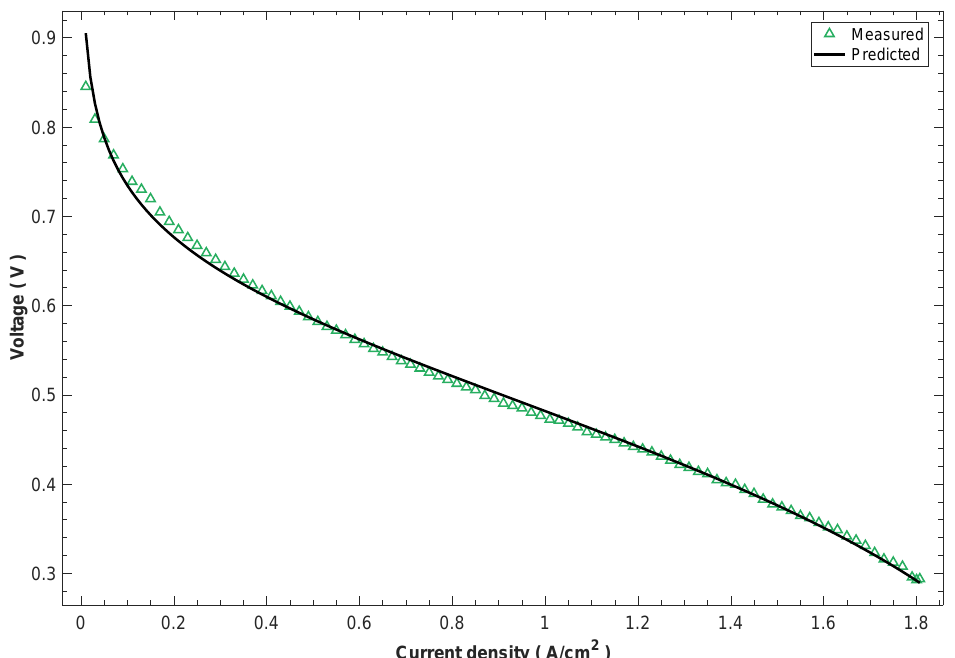
Figure 7. Modeled polarization curve using the computed unknown parameters through NNA, at 43%